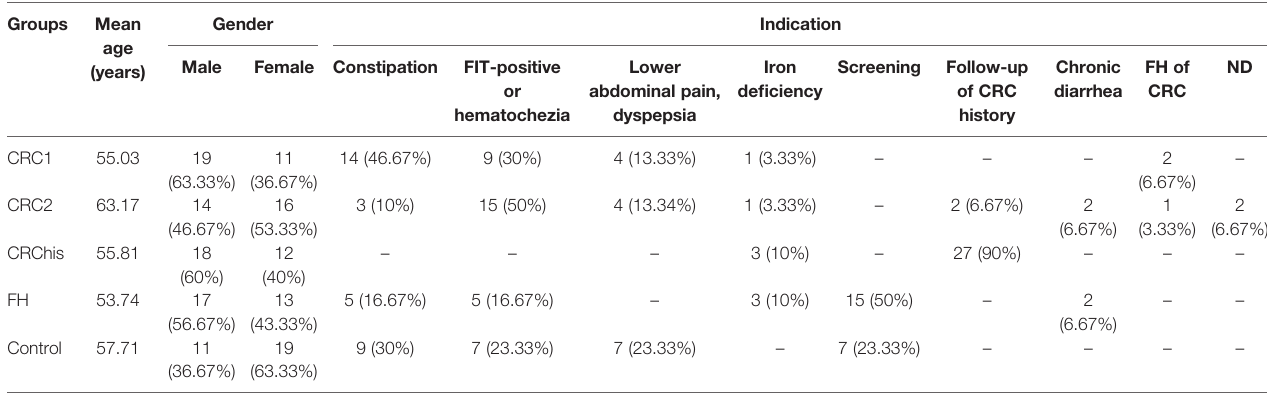
TABLE 1 | Characteristics of the study